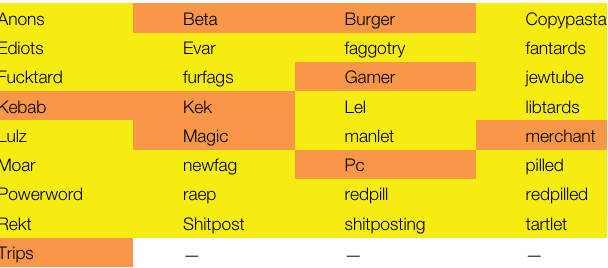
3 Using Gensim ’ s implementation of Word2Vec for Python, with vector size